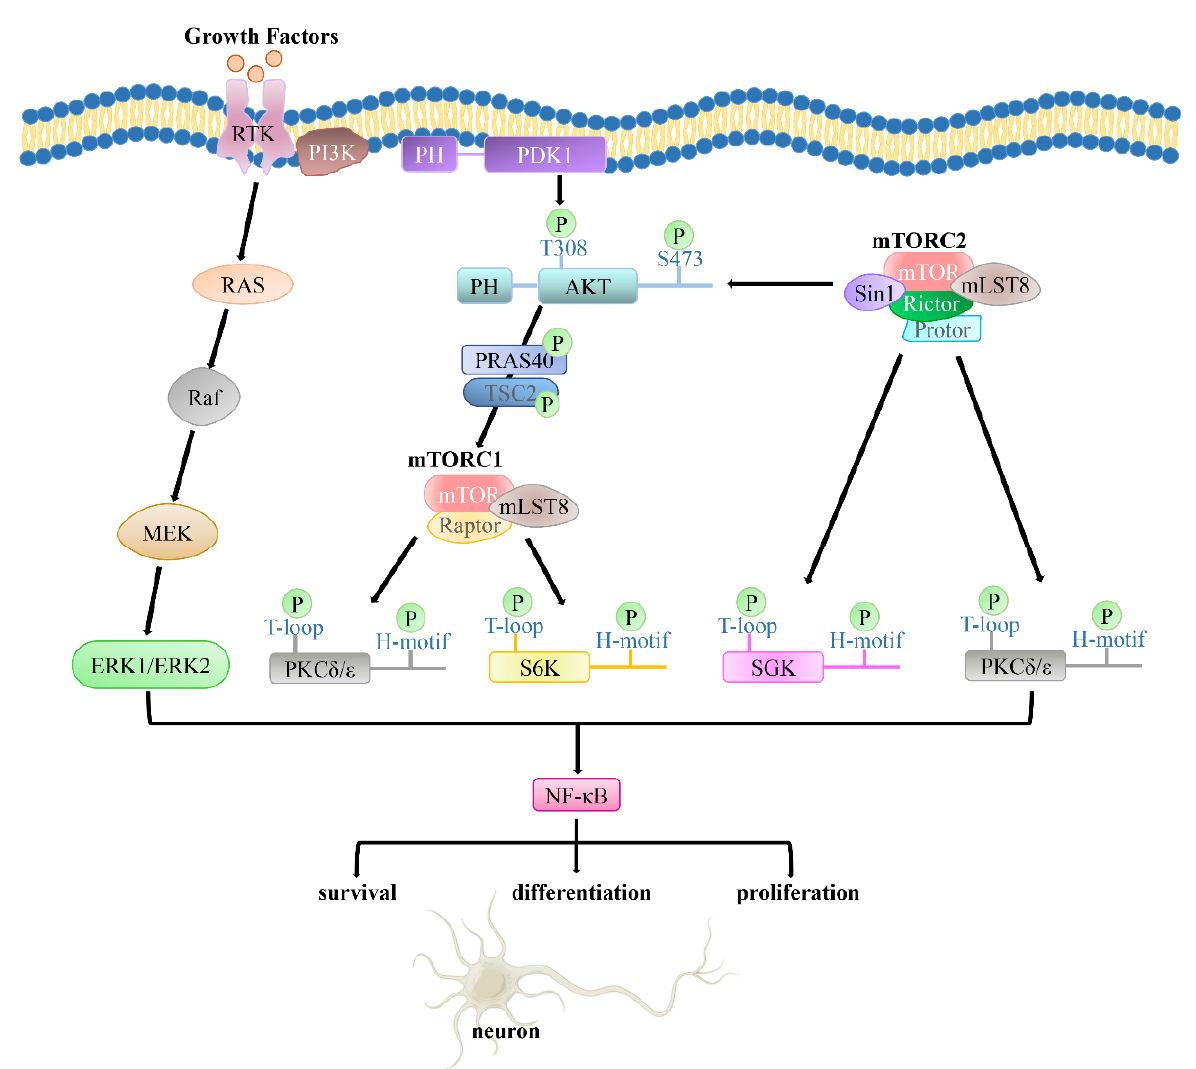
Figure 4. The PI3K/PDK1/Akt pathway plays a crucial role in cell functions, such as neuronal survival, differentiation, and proliferation, which contribute to neuronal myelination, migration, and the establishment of neuronal polarity.